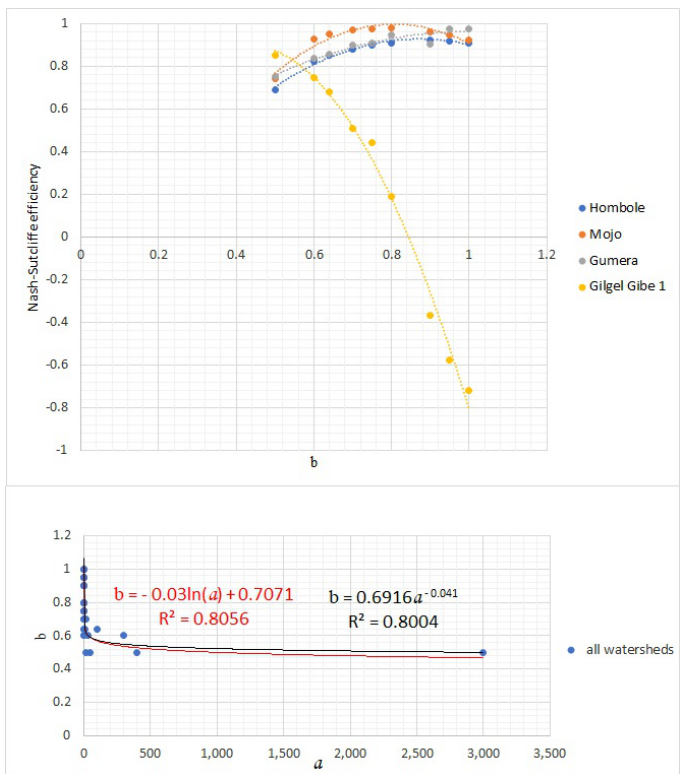
Figure 23. The relationship between exponent b versus the Nash–Sutcliffe efficiency and the coeffi- cient a versus the exponent b when the topographic factor is calculated using the equation that was proposed by [47].